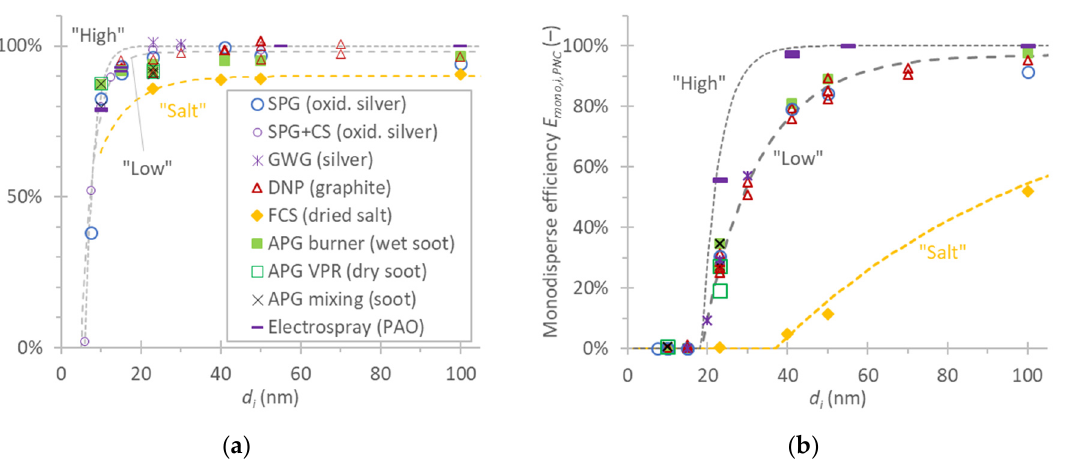
Figure 5. Monodisperse calibration of PNCs with various materials: ( a ) PNC 10 ; ( b ) PNC 23 . Lines give fittings to the experimental data of “high”, “low”, and “salt” efficiencies. The material had, in general, small impact on the counting efficiencies of the PNC 10